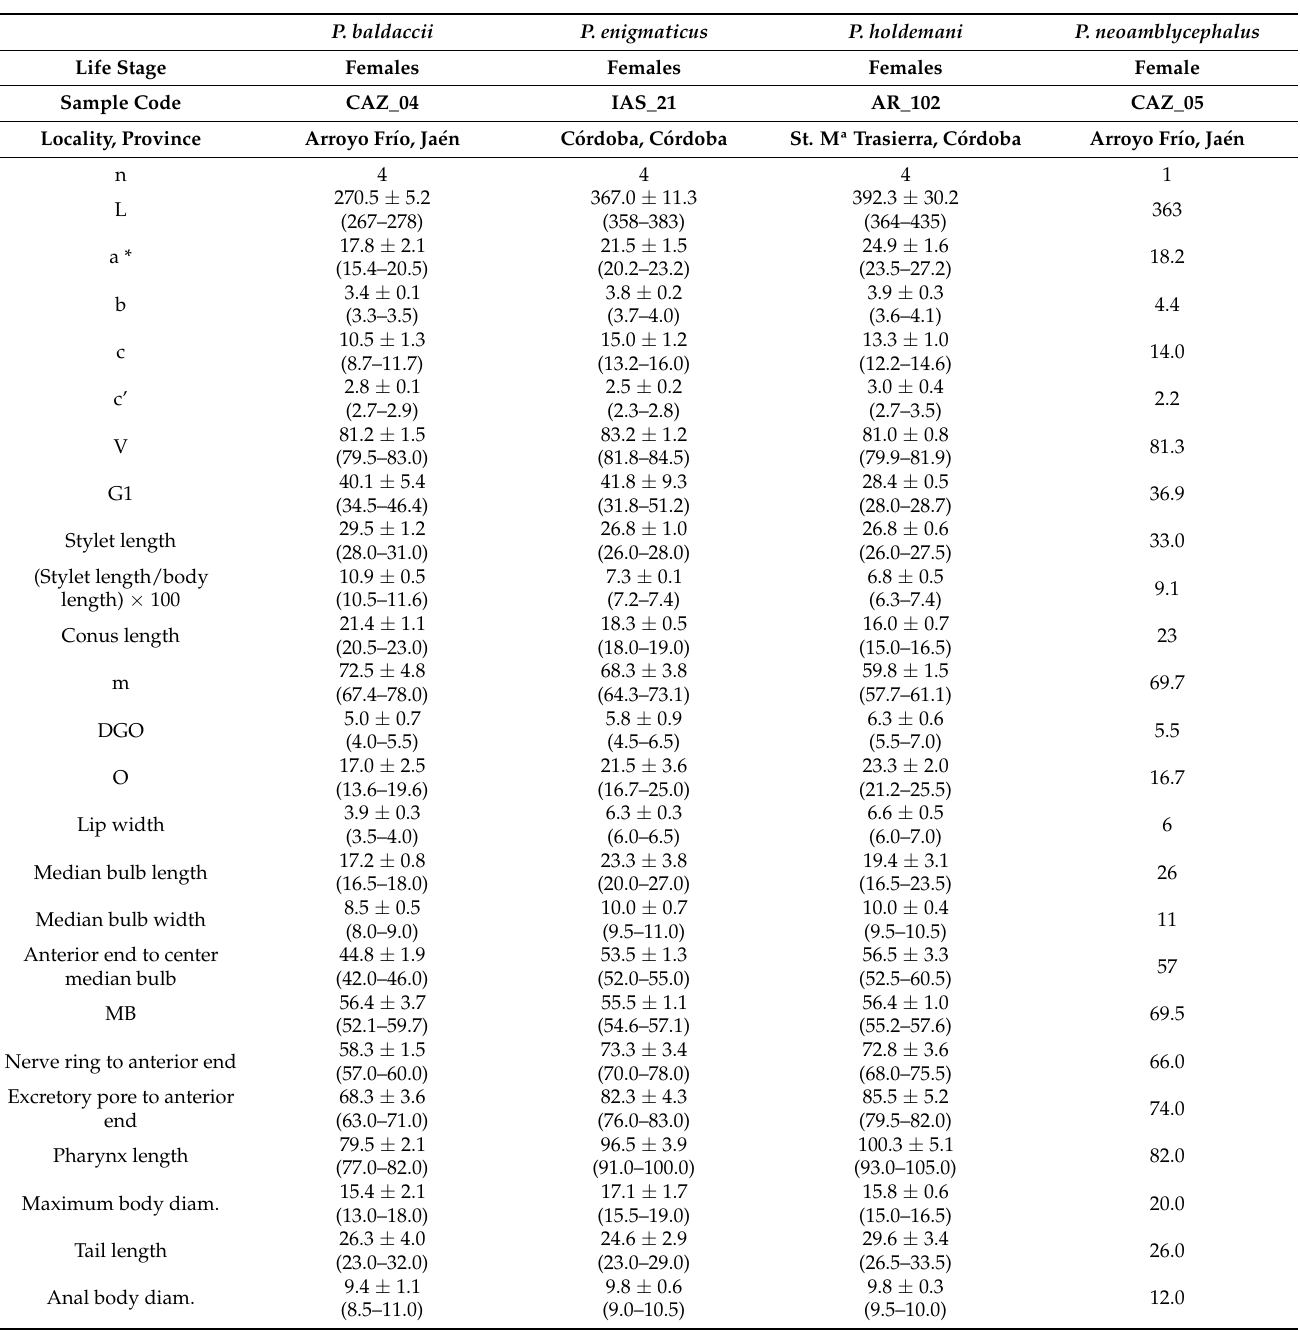
Table 5. Morphometrics of Paratylenchus baldaccii (Oostenbrink, 1953) Raski, 1962 and Paratylenchus enigmaticus Munawar, Yevtushenko, Palomares-Rius and Castillo, 2021, Paratylenchus holdemani Raski, 1975, and Paratylenchus neoamblycephalus Geraert, 1965 from several localities in Spain. All measurements are in µ m and in the form: mean ± s.d.